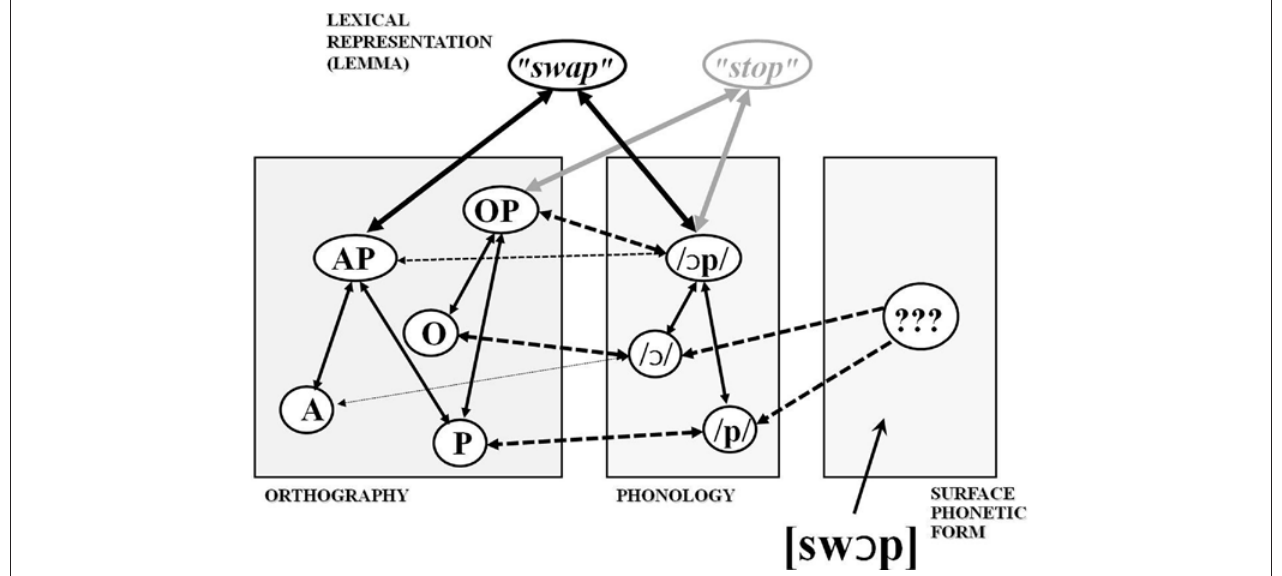
Figure 1 | An interactive-activation framework incorporating sublexical orthographic and phonological systems, along with a lemma level that captures lexical information. A phonetic input system feeds information to the phonological system, with no commitment made here as to